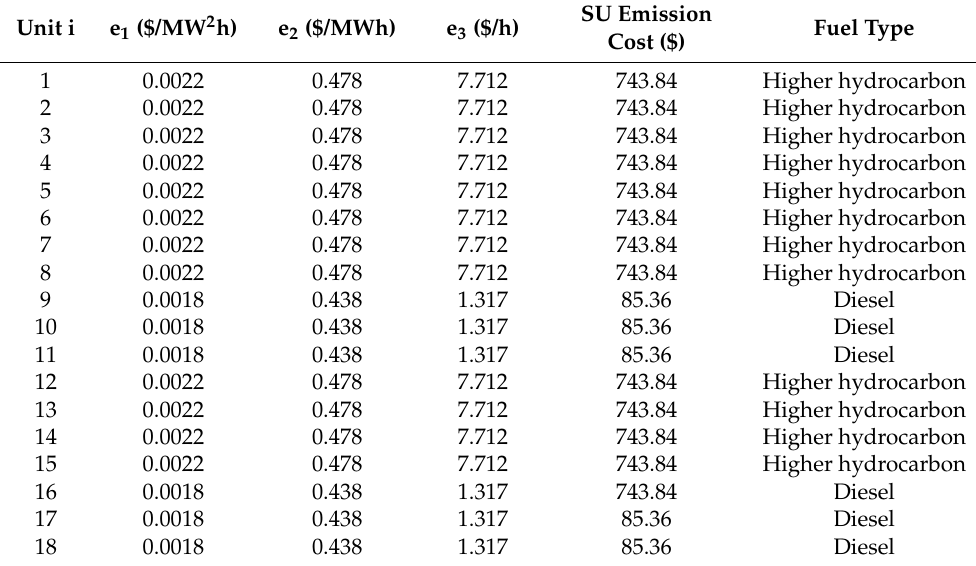
Table 4. Emission features of the thermal generating units [39].